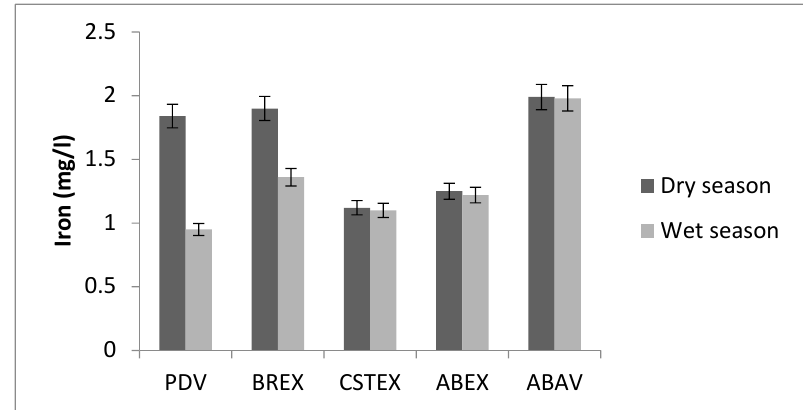
Figure 4. Iron concentration. Figure 4. Iron